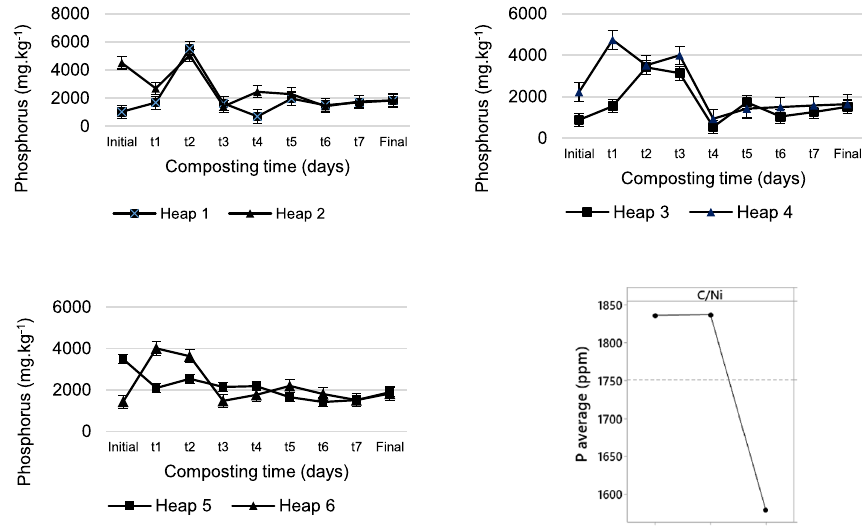
Fig. 1 Evolution of available phosphorus content during the composting period and factors’ effect diagram